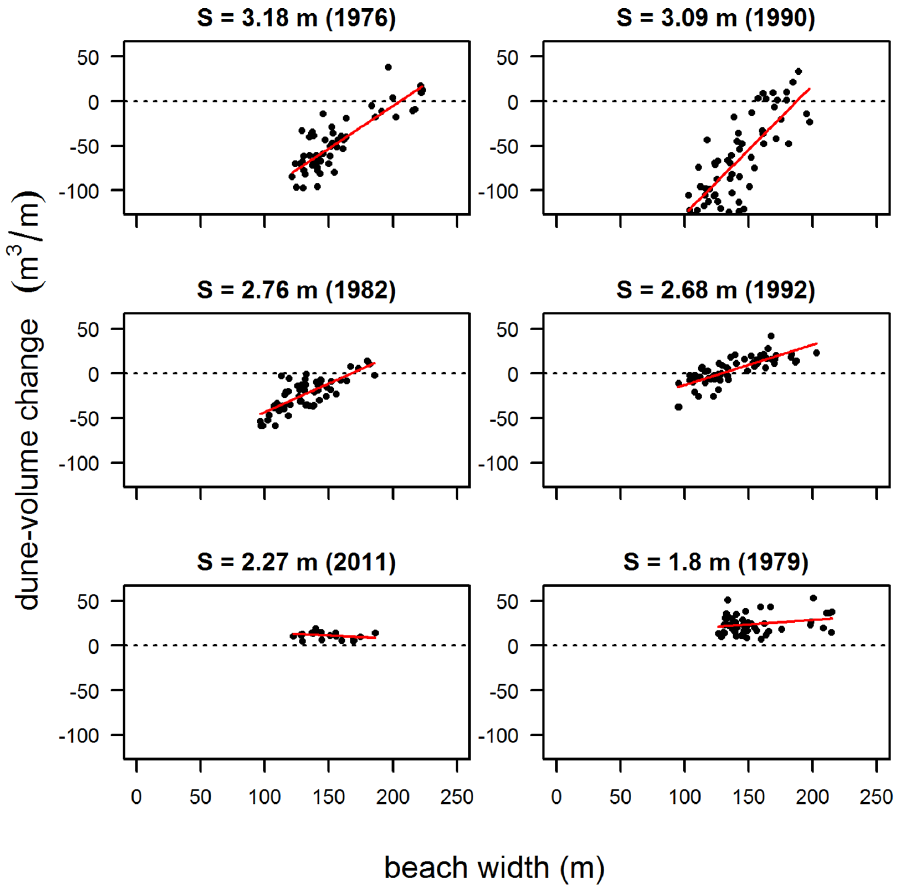
Figure 10. Correlation between dune-volume change ( D V) and beach width (W) for different values of storminess (S). Data from section Ameland. The red line represents the least squares linear regression.